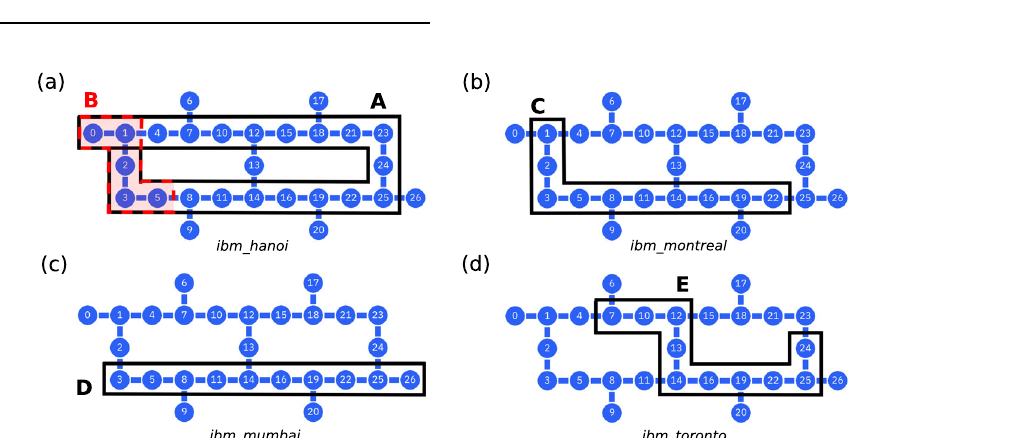
Fig. 2 a , b . c Layout for the ibm_mumbai device. Sequence D of 10 qubits used to generate the Majorana mode tomography in Fig. 2 c . d Layout for the ibm_toronto device. Sequence D of 10 qubits used to generate the topological/non-topological mode separation experiment in Fig. 2 d .